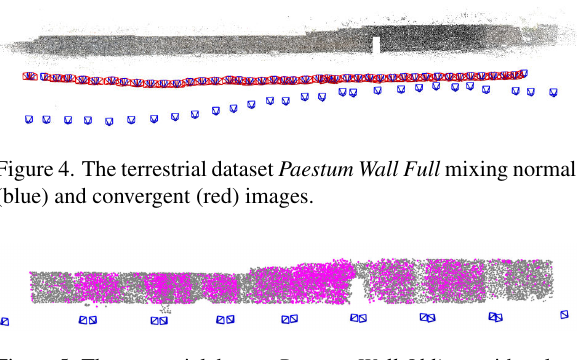
Figure 5. The terrestrial dataset Paestum Wall Oblique with only a strip of wide-baseline oblique images. The sparse model obtained ignoring two view tracks is highlighted in